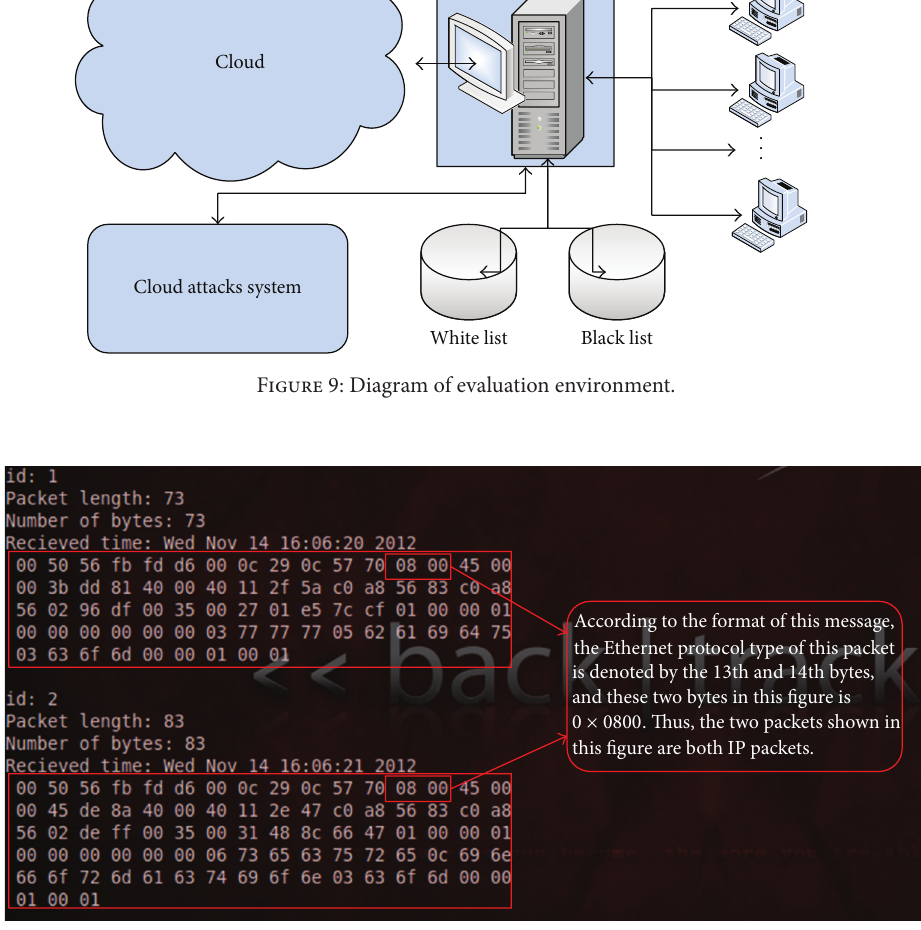
Figure 10: Data packet